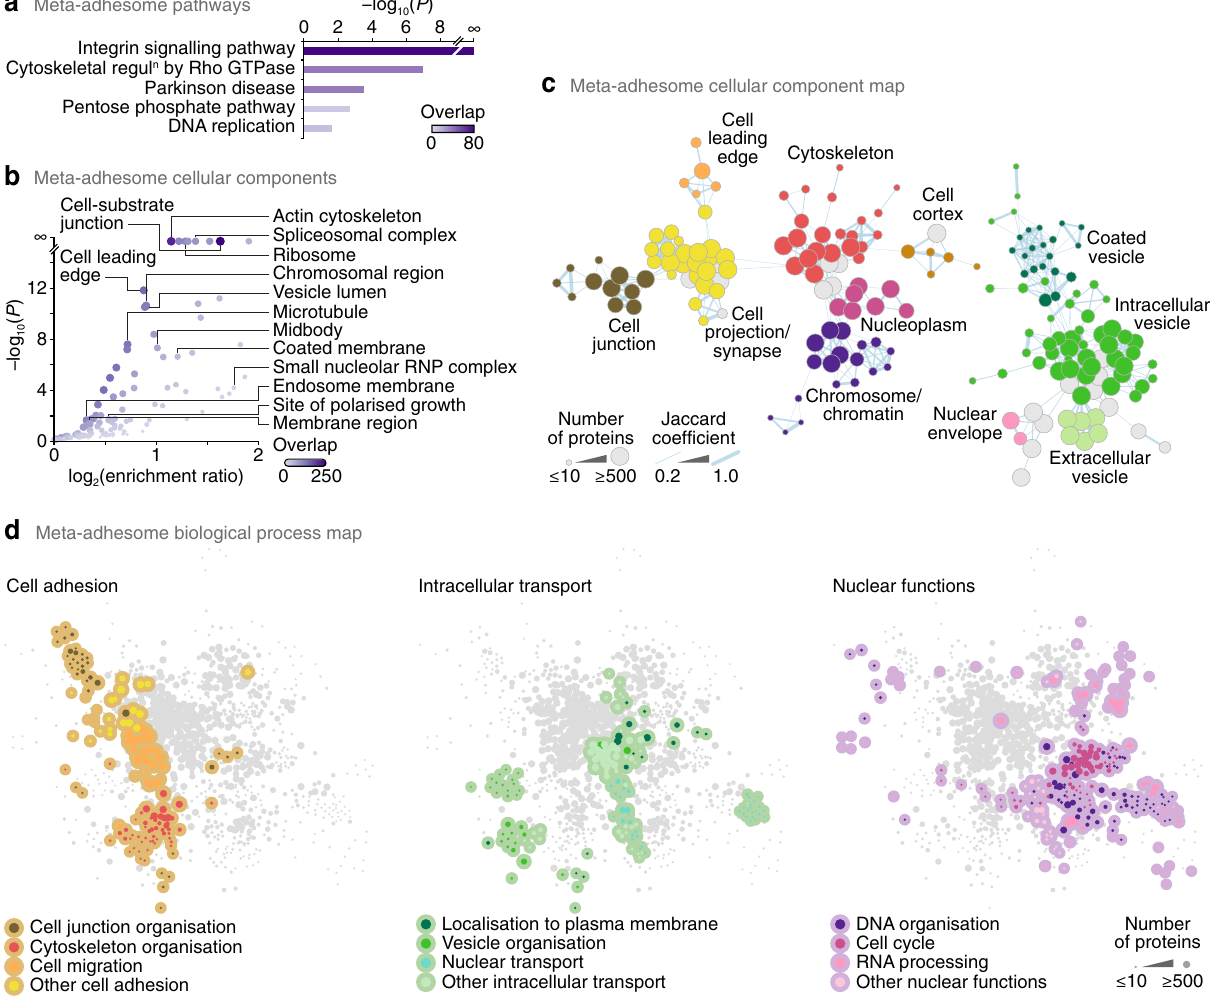
Fig. 1 Nucleus-associated adhesome proteins. a , b Over-representation analyses of PANTHER pathways ( a ) and Gene Ontology cellular components ( b ) in the meta-adhesome. Representative labelled terms were determined using af fi nity propagation, except for the terms cell-substrate junction and cell leading edge. Purple shading intensity indicates size of meta-adhesome protein overlap with respective gene sets. For a , terms with enrichment ratio (observed genes/expected genes in gene set) > 2 are displayed ( P < 0.025, one-sided hypergeometric test with Benjamini – Hochberg correction). RNP, ribonucleoprotein. c Graph-based clustering of over-represented cellular components in the meta-adhesome. A force-directed graph was generated from gene-set membership of enriched Gene Ontology terms ( P < 0.01, one-sided hypergeometric test with Benjamini – Hochberg correction). Representative cellular components summarising selected clusters of enriched terms are labelled. Node (circle) size represents the number of meta-adhesome proteins annotated for each enriched term; node fi ll colour represents cellular component annotation. Edge (line) weight is proportional to the overlap of gene-set membership of connected nodes (Jaccard coef fi cient ≥ 0.2). The two largest connected components are shown (see also Supplementary Fig. 1b). d Graph- based clustering of over-represented biological processes in the meta-adhesome. Enriched Gene Ontology terms associated with cell adhesion (left panel), intracellular transport (middle panel) and nuclear functions (right panel) are coloured as indicated. The largest connected component is shown, and edges were omitted for clarity (see Supplementary Fig.